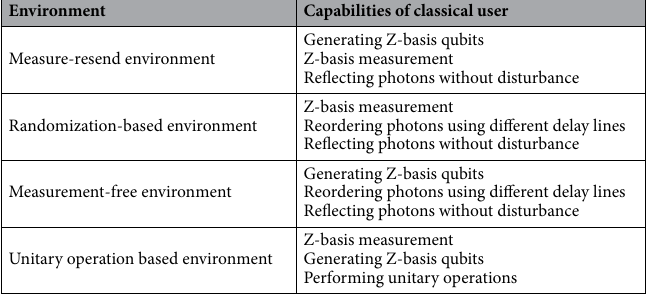
Table 1. Summary of semi-quantum environment.